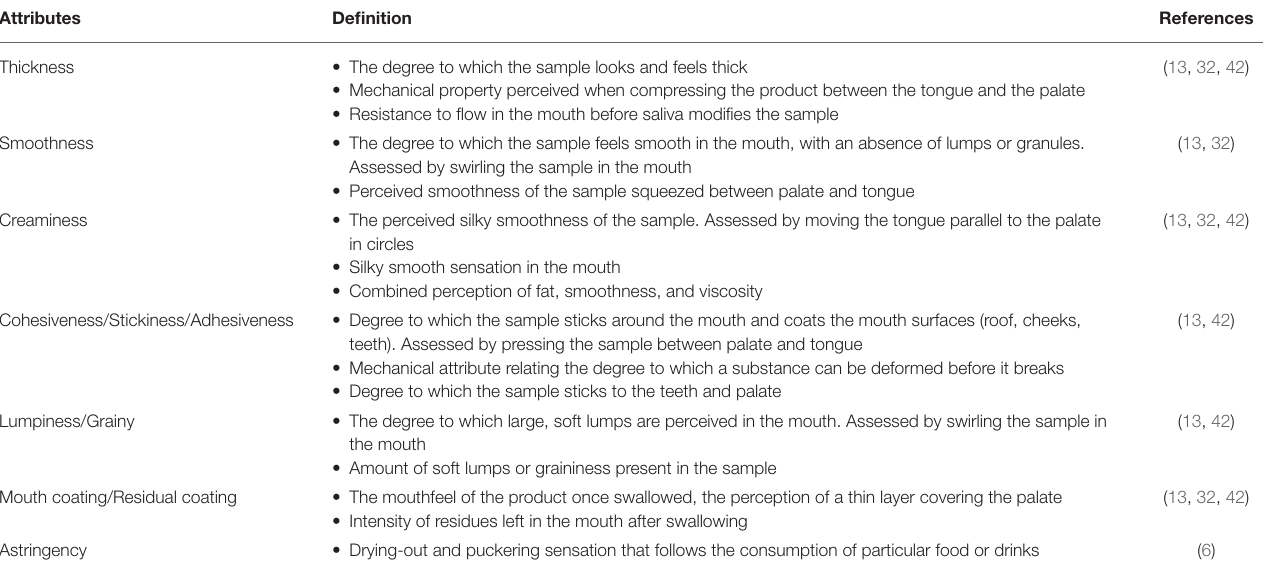
TABLE 2 | Definitions of sensory attributes in dairy